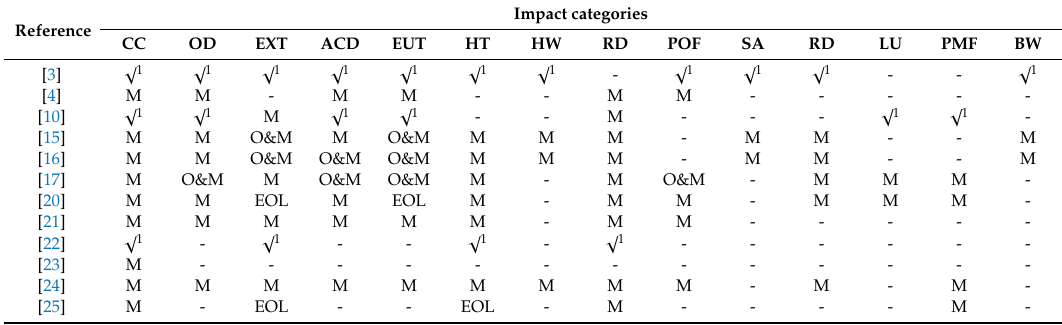
Table 5. Life cycle impact categories and association with most significant